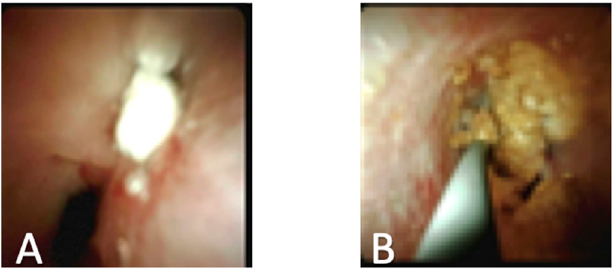
Figure 4. ( A ) Pancreatic duct stone; ( B ) Passing of wire by pancreatic duct stone.